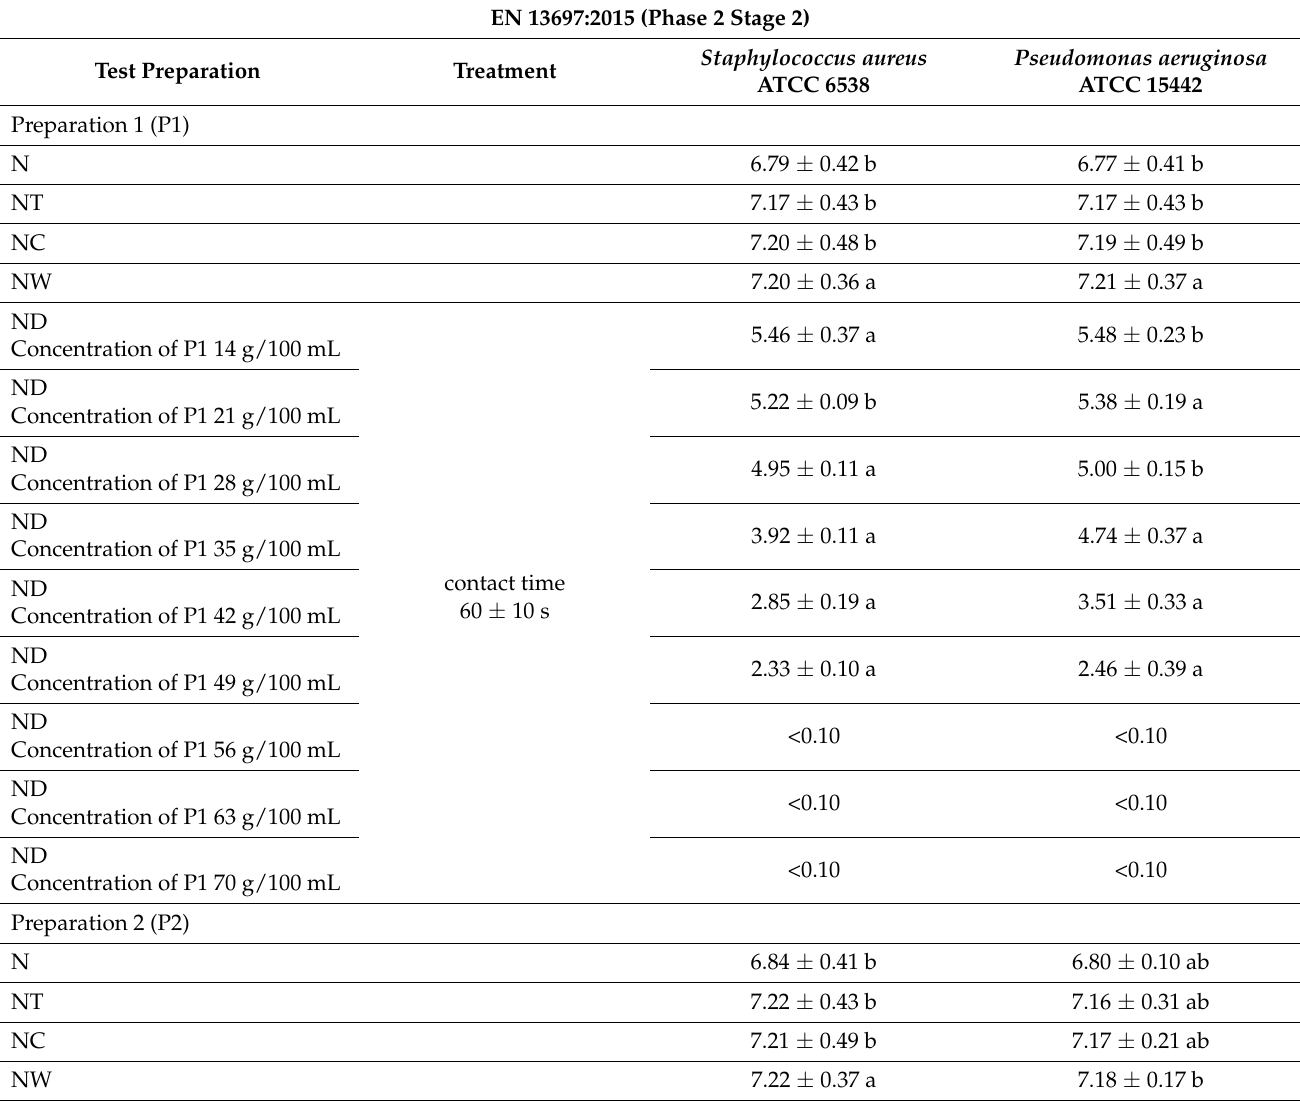
Table 8. The conditions for determining surface disinfection tests of plant preparations by standard EN 13697:2015. EN 13697:2015 (Phase 2 Stage